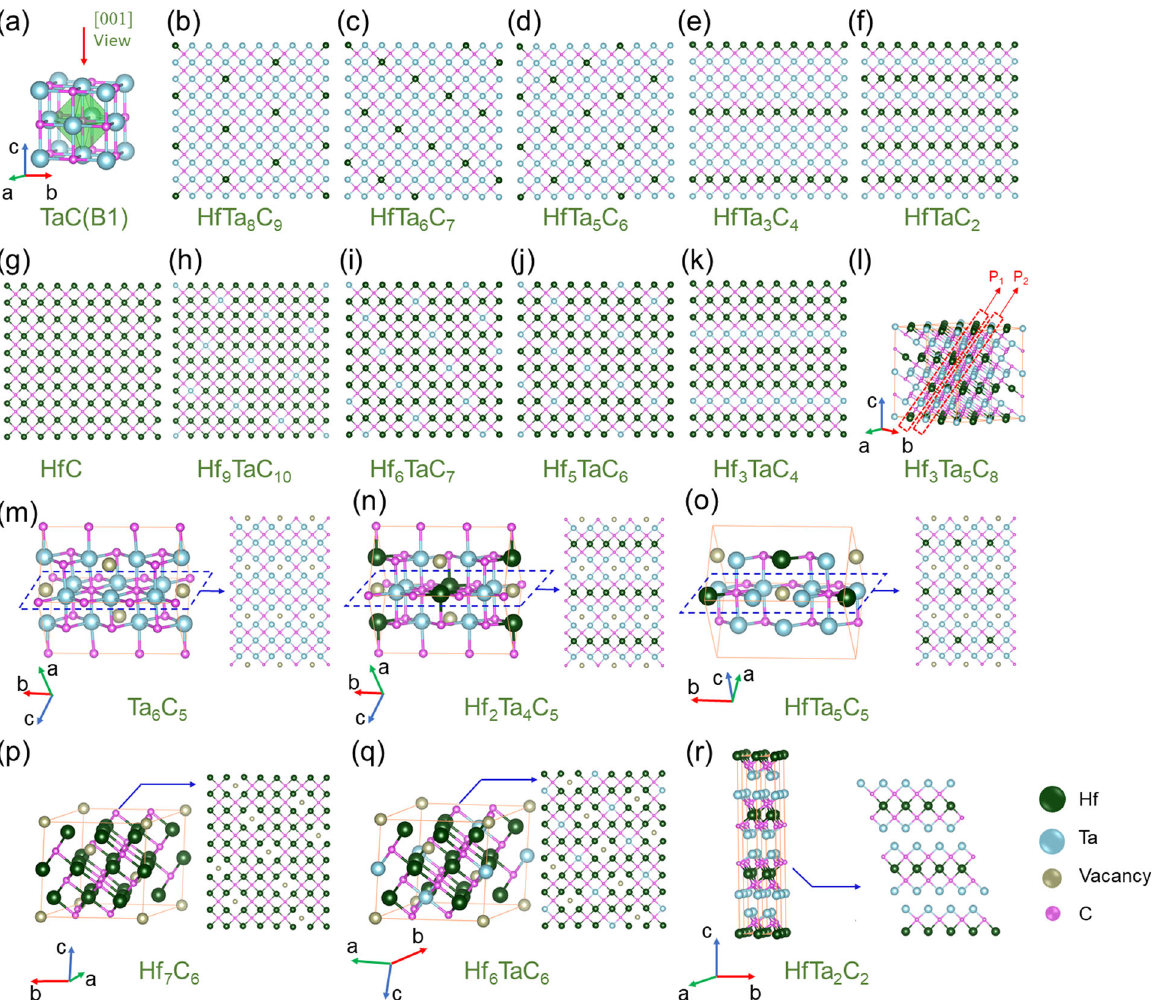
Fig. 7 Crystal structures of the phases in the Hf – Ta – C system. a Crystal structure of TaC, and the two-dimensional projections (along the [001] direction of the B1 structure) of the structures b HfTa 8 C 9 , c HfTa 6 C 7 , d HfTa 5 C 6 , e HfTa 3 C 4 , f HfTaC 2 , g HfC, h Hf 9 TaC 10 , i Hf 6 TaC 7 , j Hf 5 TaC 6 , k Hf 3 TaC 4 . l The crystal structure of Hf 3 Ta 5 C 8 is formed by alternation of one layer of HfTaC 2 (denoted as P 1 ) and one layer of HfTa 3 C 4 (denoted as P 2 ). Crystal structures and their projections along the [001] direction of the B1 structure: m Ta 6 C 5 , n Hf 2 Ta 4 C 5 , o HfTa 5 C 5 , p Hf 7 C 6 , q Hf 6 TaC 6 , r HfTa 2 C 2